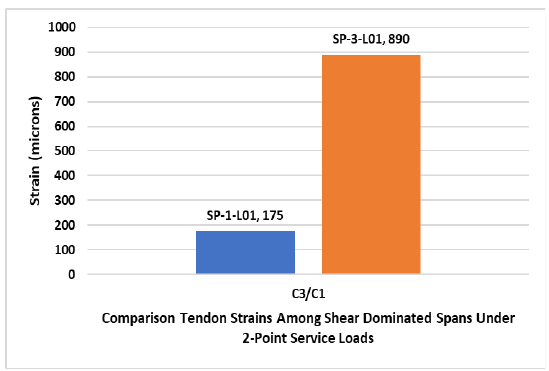
Figure 44. Comparison of maximum tendon strains recorded under two-point service loads between specimen SP-1 and SP-3.